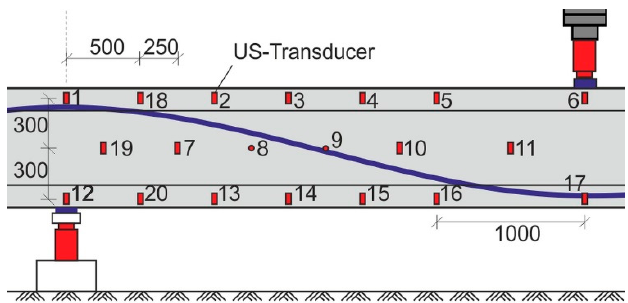
Figure 10. ( a ) Custom-designed ultrasonic transducer ACS S0807 for embedment into concrete; ( b ) Transducer mounted to a reinforcement cage using 3D-printed adapters.